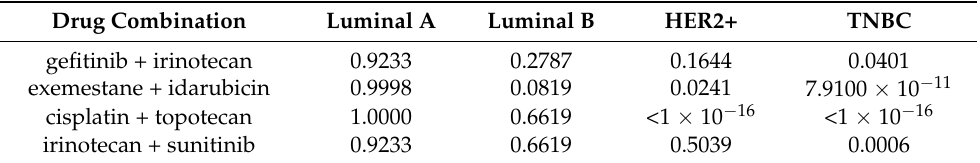
Table 6. Subtype prediction results for four drug combinations ( p -values evaluated with